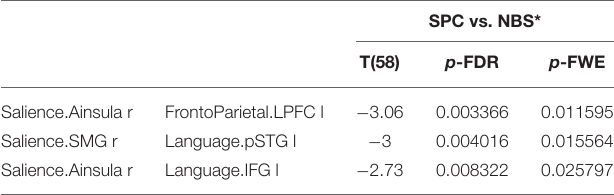
TABLE 6 | The significant decrease in functional connectivity in older females observed only in SPC analysis, not revealed in NBS method.